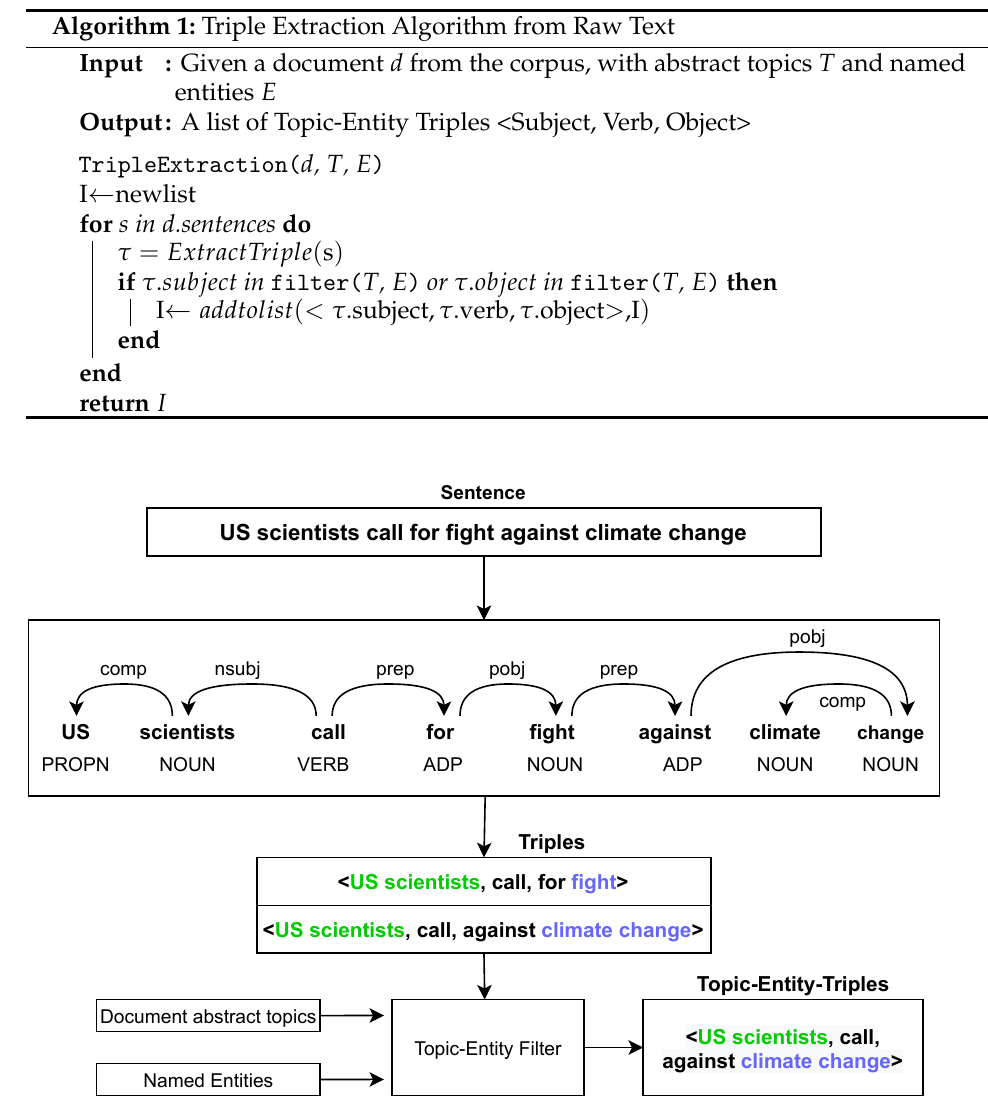
Figure 2. An example of Topic-Entity Triple extraction from a sentence in Energy-Hub corpus. A pre-trained spaCy model is applied to get syntactic dependencies of each term and subsequently form Triples. Each triple is passed through a filter to compare with extracted named entities, and topic keywords in order to consider them as Topic-Entity